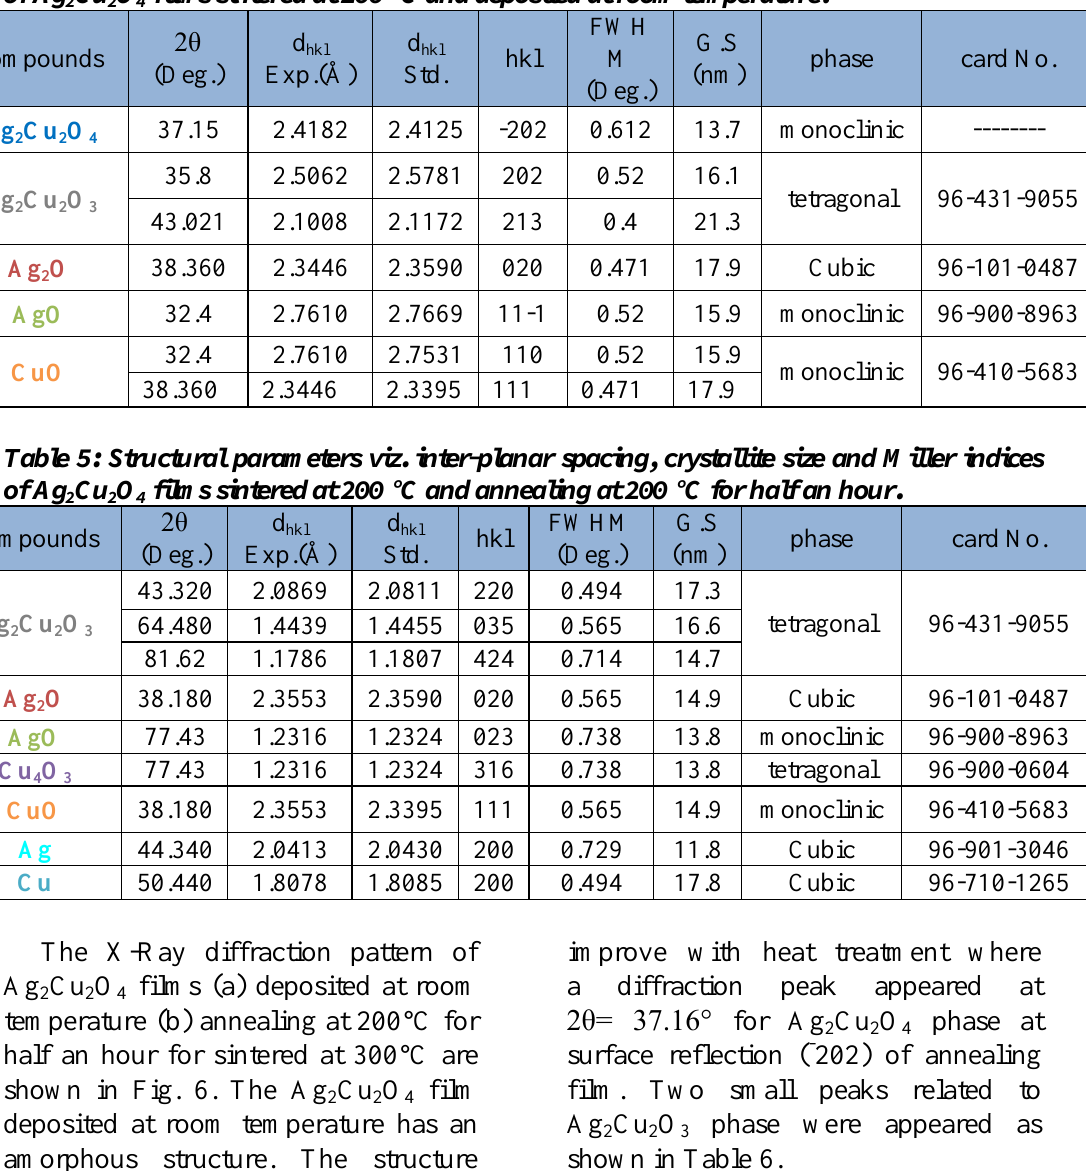
Fig.5: X-ray diffraction pattern of Ag temperature (b) annealing at 200°C for half an hour. Table 4: Structural parameters viz. inter-planar spacing, crystallite size and Miller indices of Ag Cu O films sintered at 200 °C and deposited at room temperature. 2 2 4 compounds card No.